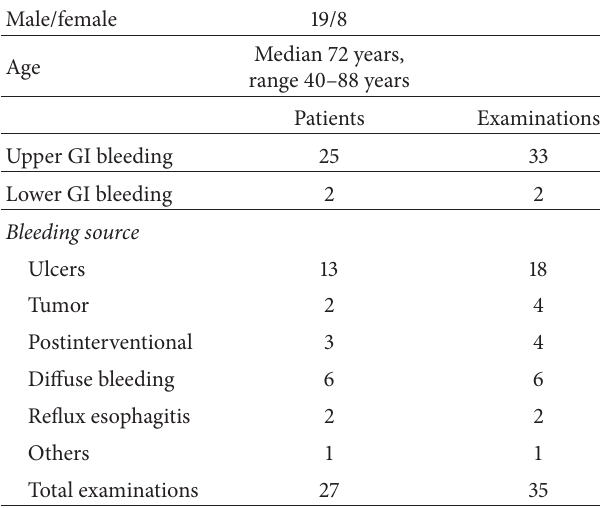
Table 1: Patient characteristics and frequency distribution of the treatment indications. In several patients suffering from upper GI bleeding, more than one endoscopy involving hemostatic mea- sures and the application of Hemospray was necessary. Hence, we recorded more examinations involving interventional measures than patients. Merely second look endoscopies without further necessary interventions have not been calculated here.